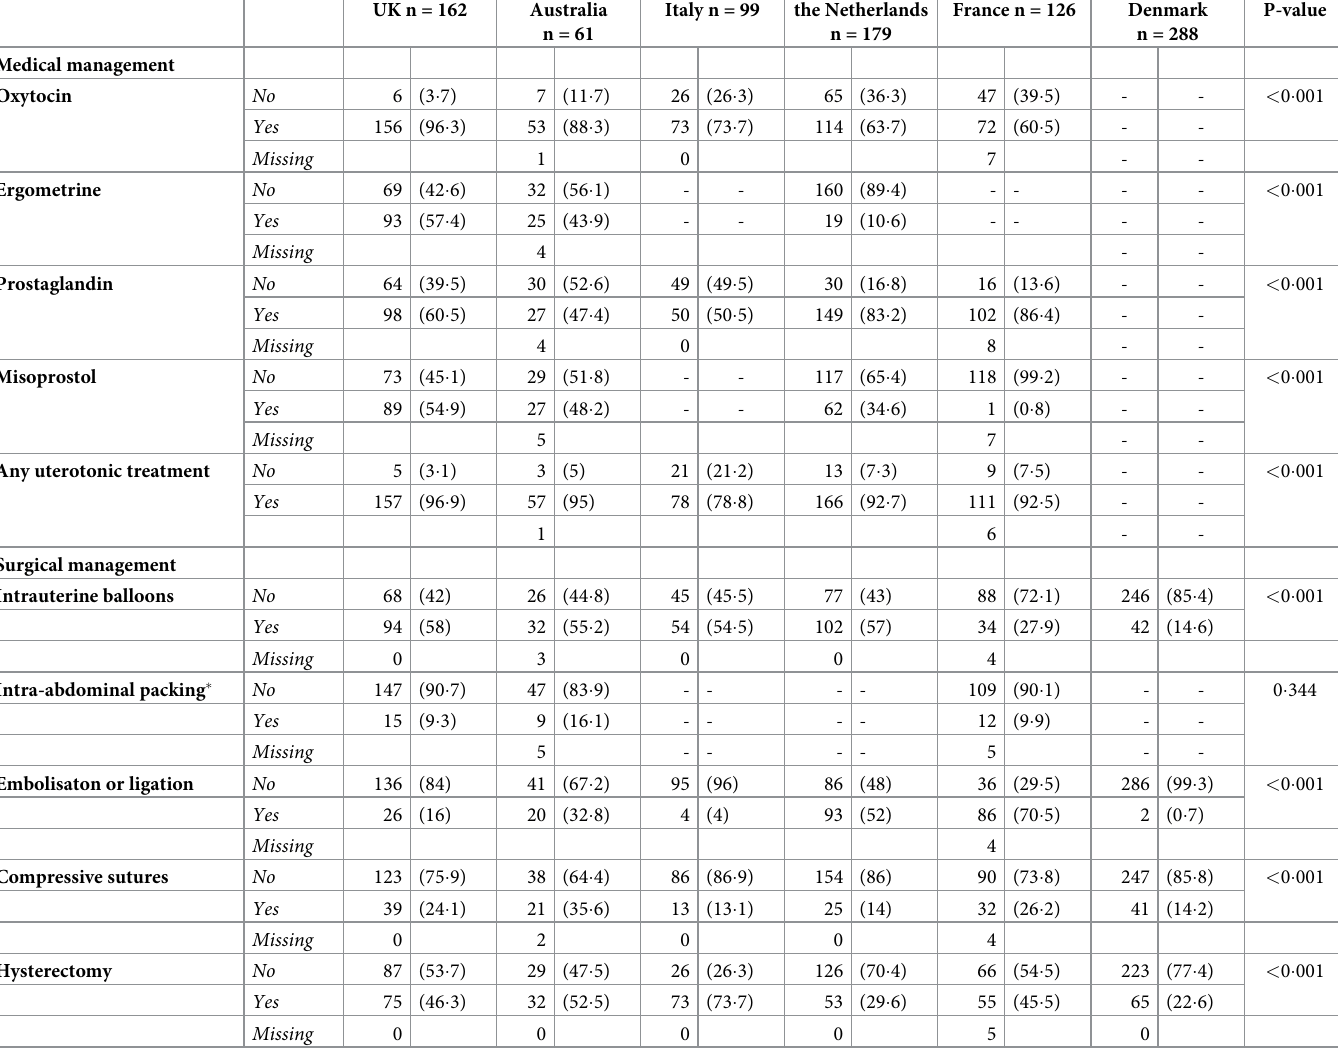
Table 4. Obstetric management by